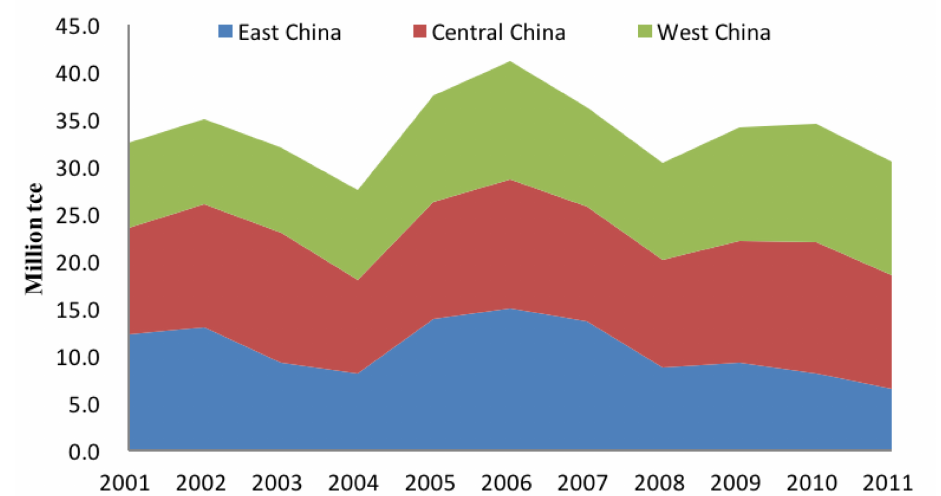
Figure 3. Total energy savings potential in the east, central and